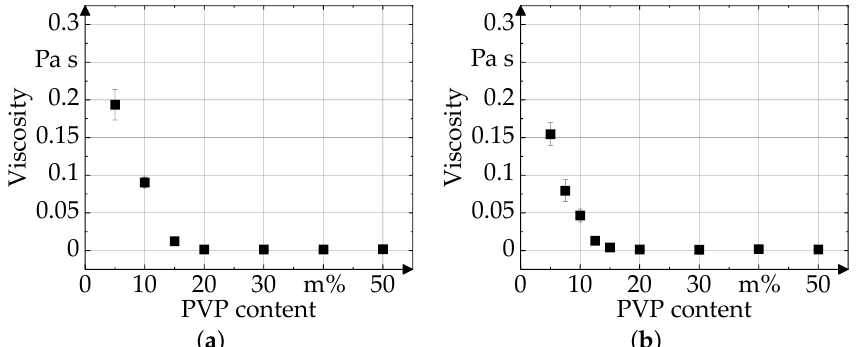
Figure 7. Viscosity as a function of PVP content for aqueous dispersions containing 10 m% graphite nanoparticles at varying pH values ( a ) pH = 9.0–9.5 (see Table A1) and ( b ) pH = 7.8 (see Table